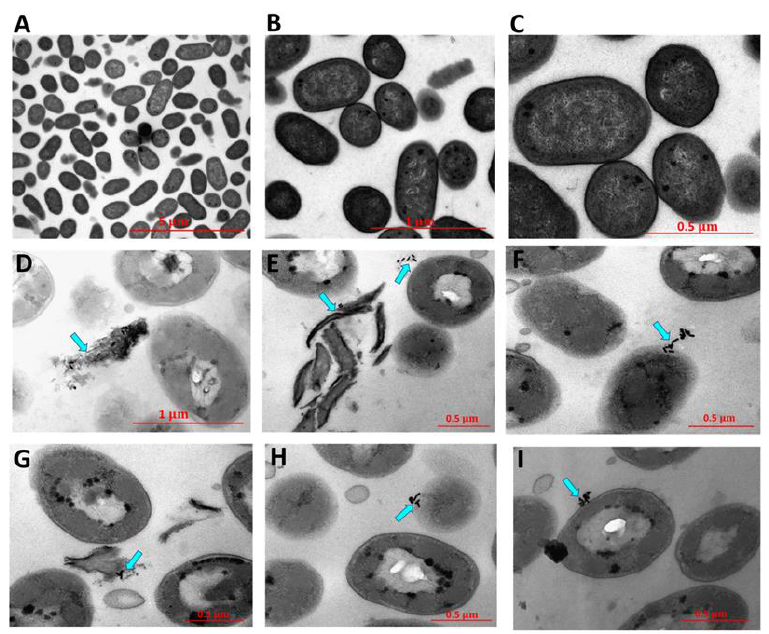
Figure 4. TEM images of untreated Pseudomonas aeruginosa ( A – C ) and after treatment with DSPE- AuNR and excitation with a continuous (CW) laser beam ( D – I ). Photothermal therapy resulted in significant changes in the morphology of the bacteria and lysis of bacterial cells. Reproduced from [62], with permission from MDPI, 2019.